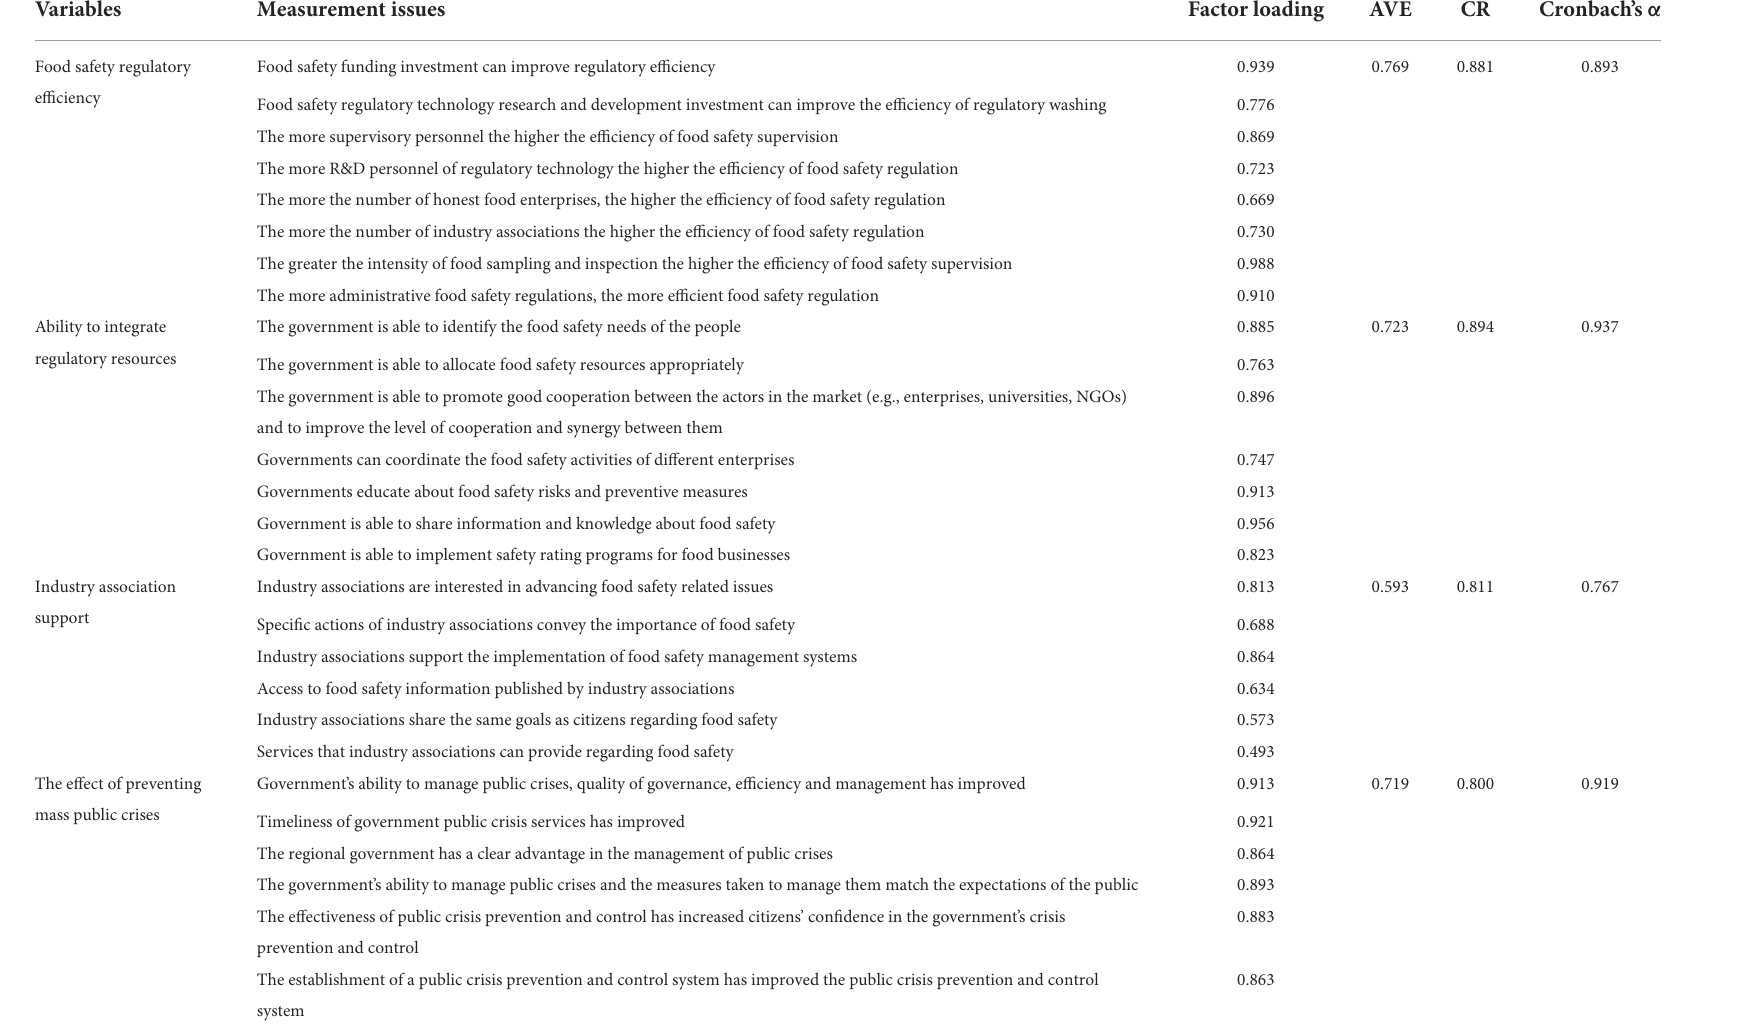
TABLE 4 Reliability and validity tests of the questionnaire measurement